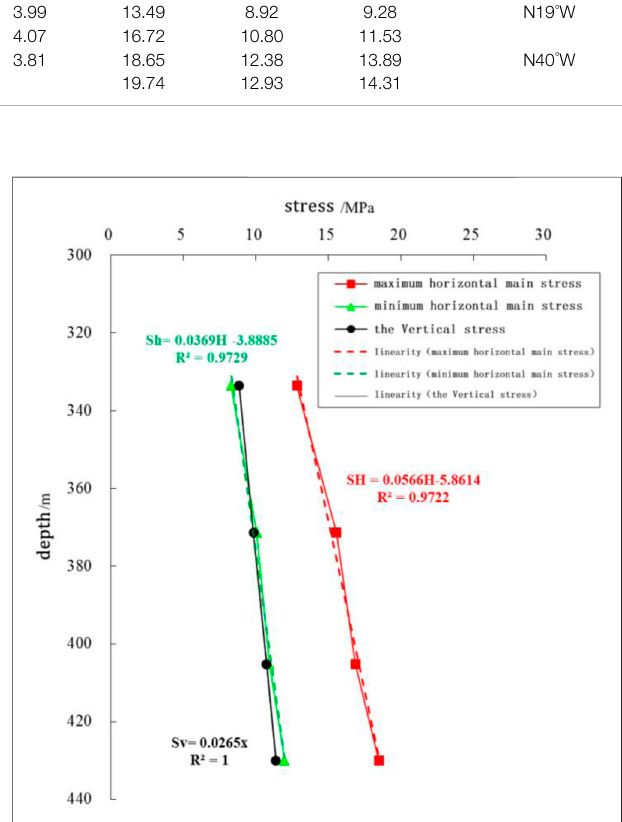
FIGURE 6 | Changes in principle stress of DZ-YL-08 borehole with